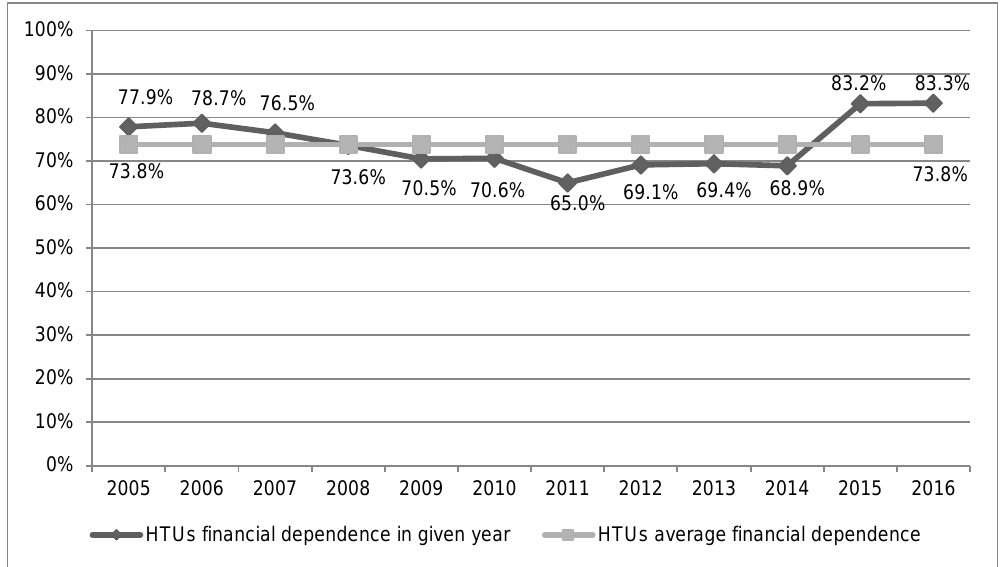
Figure 2: The rate of financial dependence of HTUs in a given year and the average rate of financial dependency for the years 2005-2016 (%). Source: Authors´